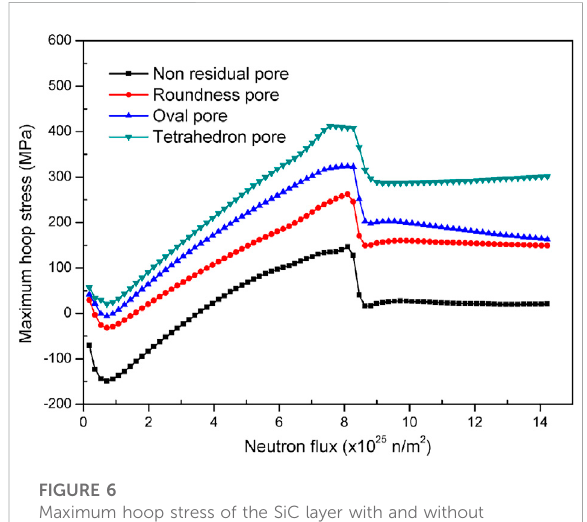
Maximum hoop stress of the SiC layer with and without residual pores.